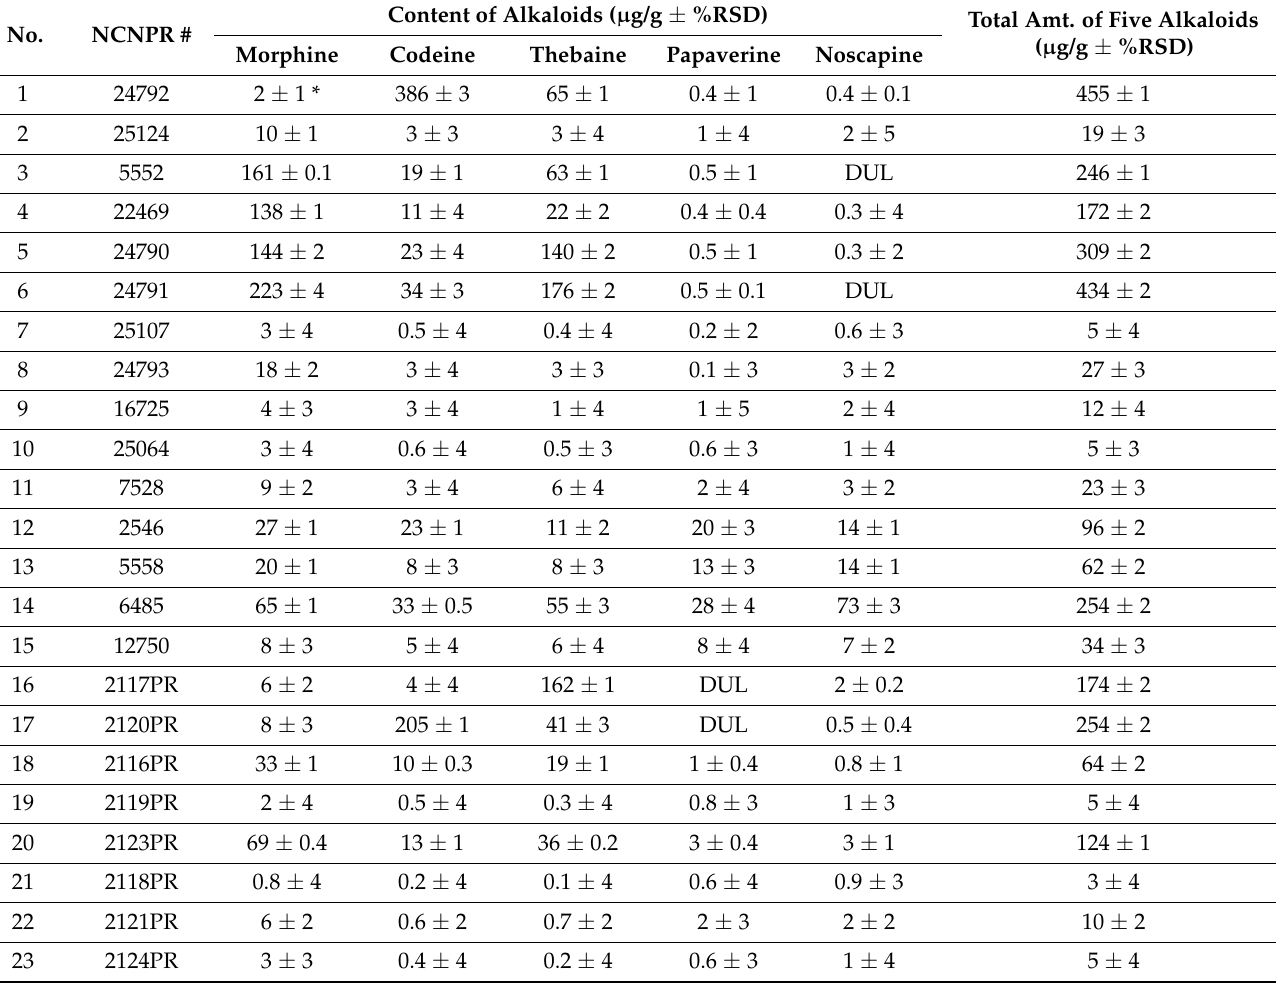
Table 3. Content of µ g/g of different alkaloids in various ground poppy seeds using